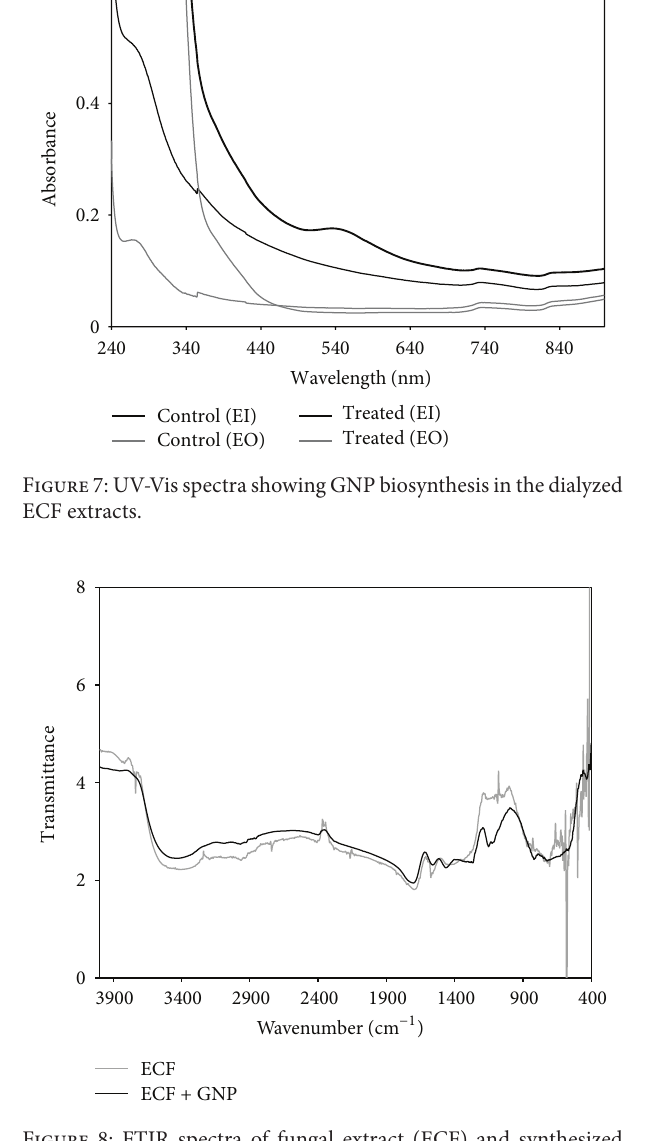
Figure 8: FTIR spectra of fungal extract (ECF) and synthesized